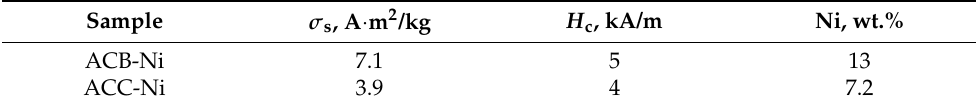
Table 1. Magnetic properties of synthesized Ni/C